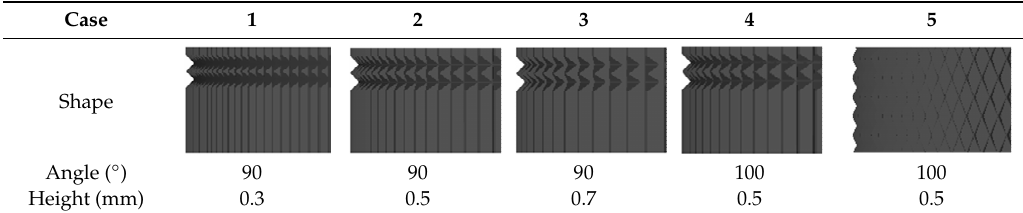
Figure 4. Angle ( α ) and height ( h ) of the serration of steel inner. Table 2. Five shapes of serration on the joining plane.